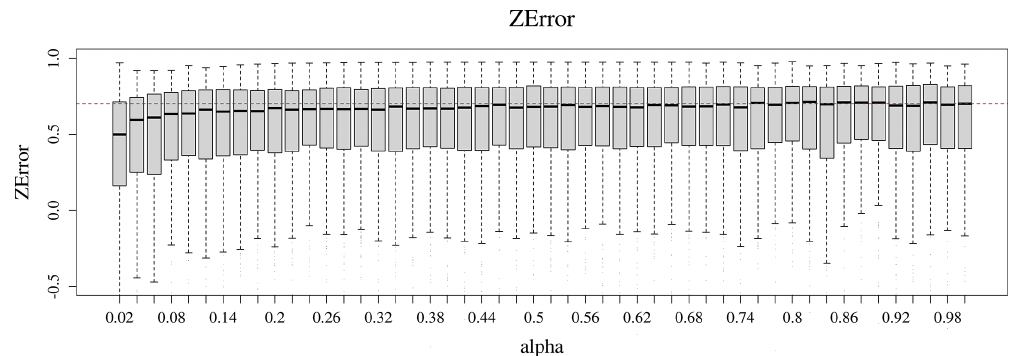
Figure 7. Distributions of the Z Error criterion values obtained for 50 values of α , the criterion weight. α = 0 was discarded since no ground- water level simulation is performed for that case. The dashed red line indicates the median Z Error value obtained with α = 1. Values be- low − 0 . 5 are cut off for readability.